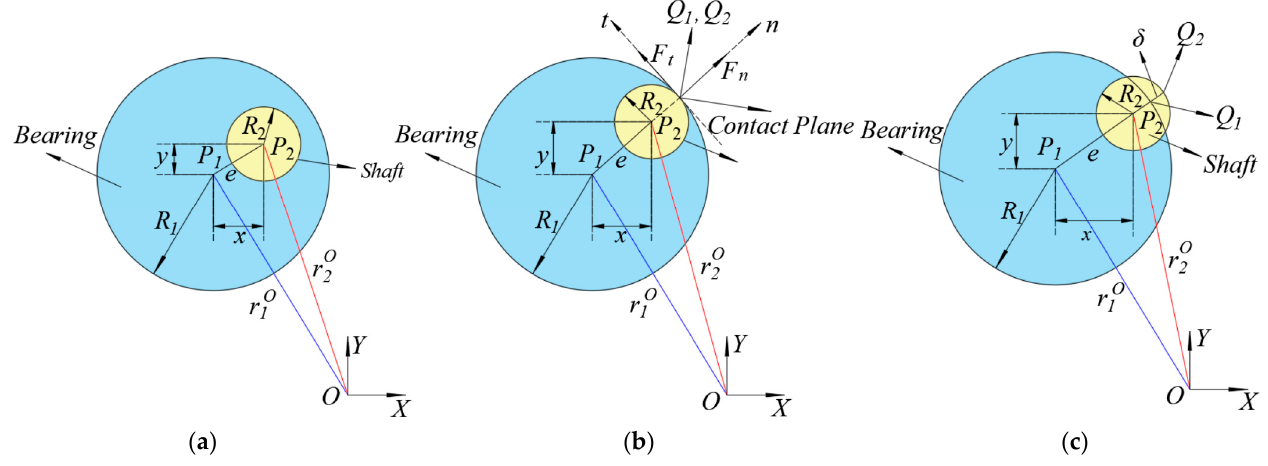
Figure 2. The motion mode of revolute clearance. ( a ) Free flight state; ( b ) continuous contact state; ( c ) impact state.